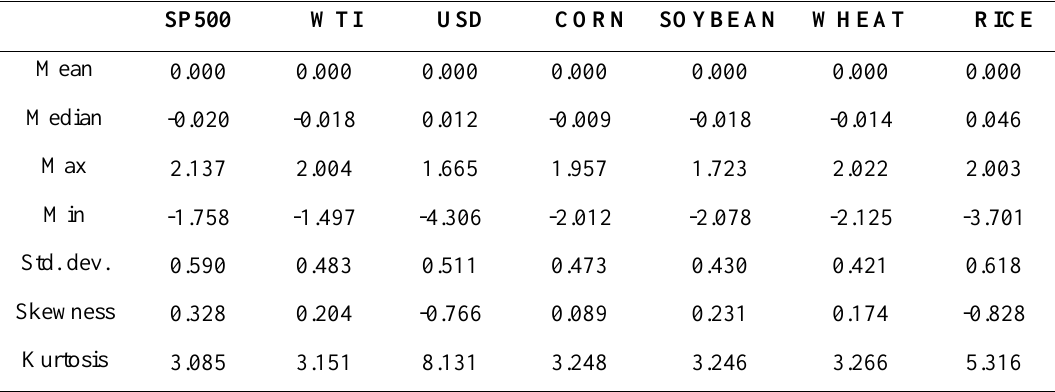
Table 1: Descriptive statistics of log range volatility for seven